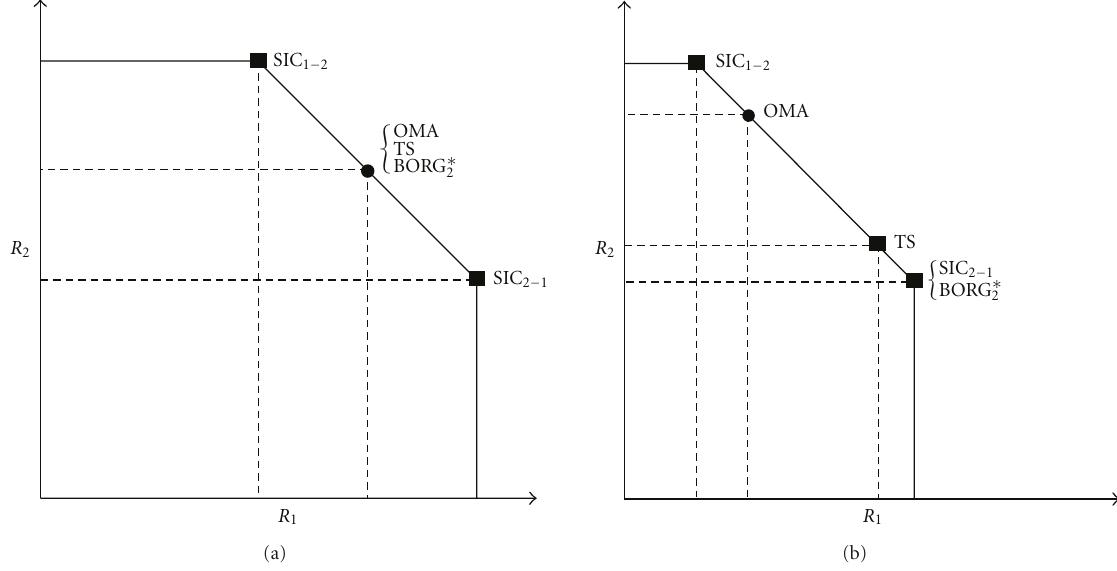
Figure 1: The polymatroid B ( f , G ) when K = 2 users. The points marked on the sum-capacity facet correspond to various MA methods. Here, SIC i − j means that user i is decoded before user j . Two di ff erent cases are considered: (a) homogeneous network ( P 1 = P 2 ), (b) heterogeneous network ( P 1 (cid:14) P 2